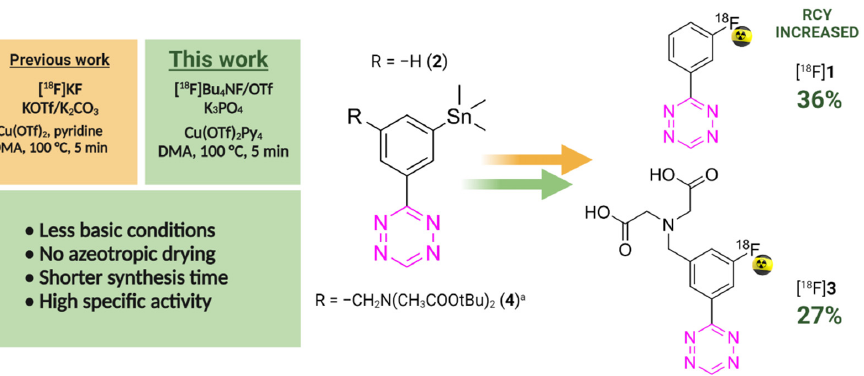
Figure 1. Overview of this work. Previous approach (orange); the new approach reduces the amount of base needed, removes the azeotropic drying step, results in a shorter synthesis time and higher RCY (green). a The reaction proceeds in a two step, one pot sequence. Table 1. Parameters explored for the optimization of the labeling of [ 18 F] 1 . Parameters